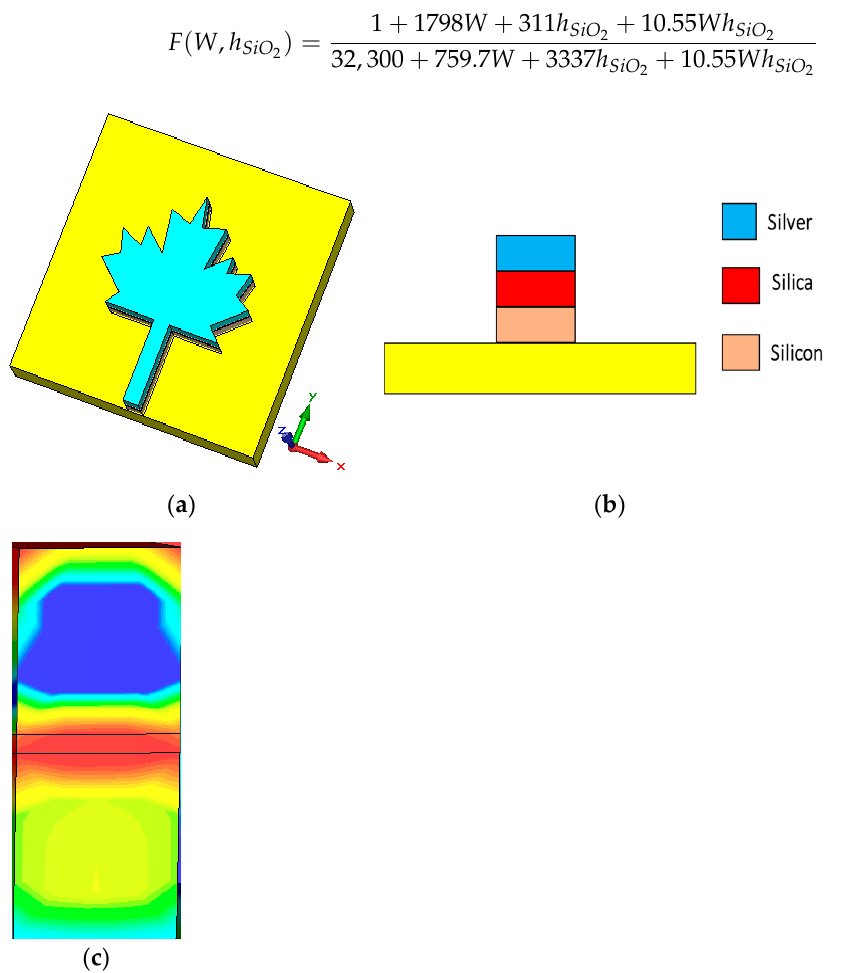
Figure 1. ( a ) Perspective view of the structure; ( b ) basic geometry of HPWG; and ( c ) TM mode.